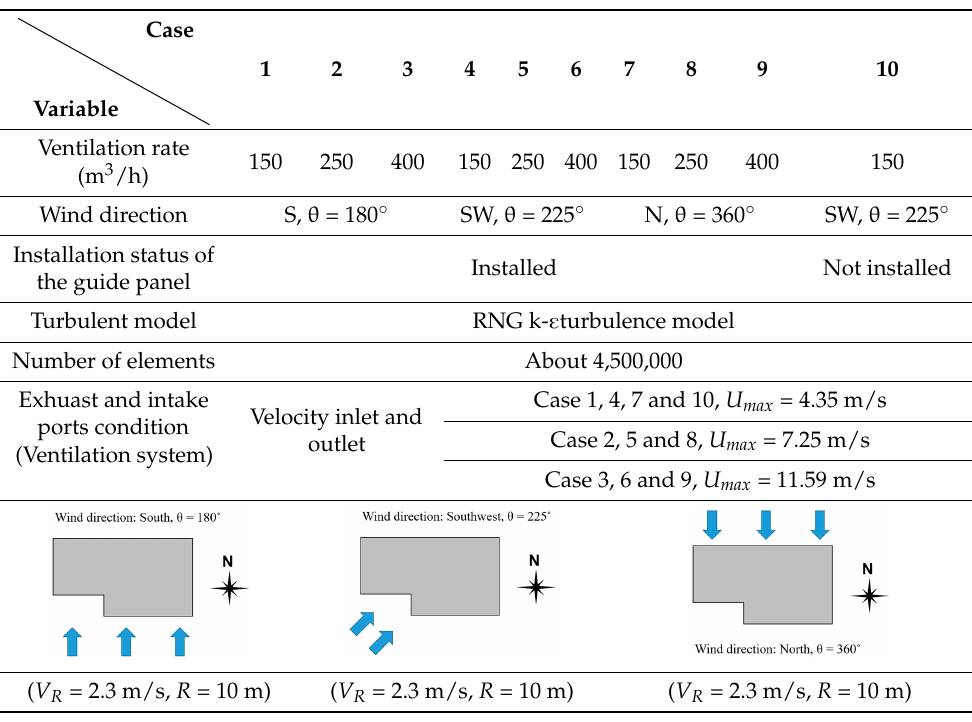
Table 1. Cases and boundary condition for CFD analysis.